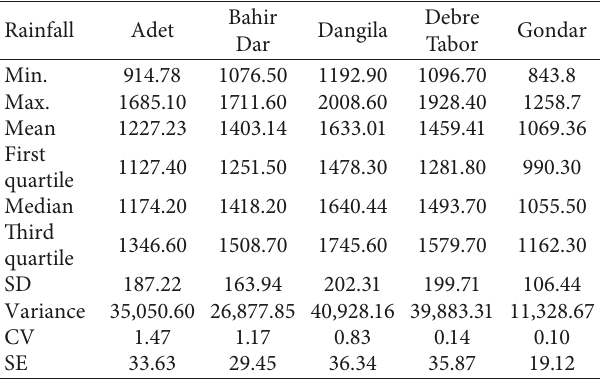
Table 1: Geographical description of the meteorological stations and rainfall data record period. General